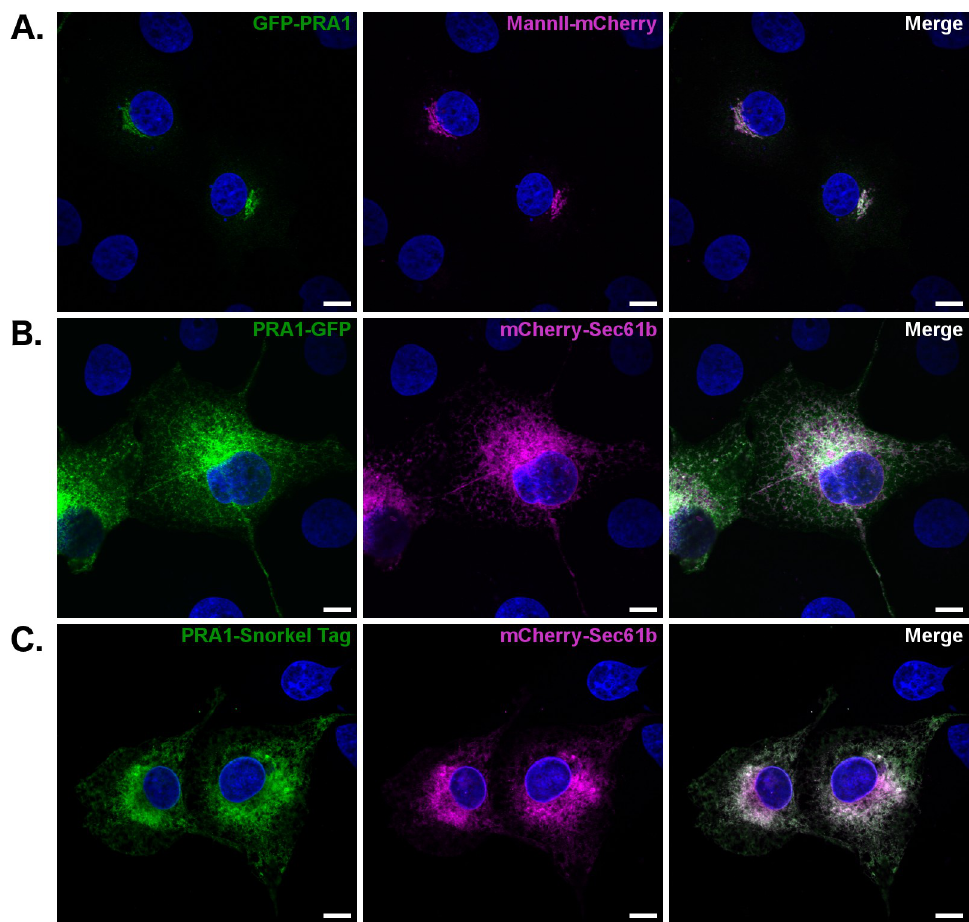
following constructs were expressed in COS-7 cells: (A) GFP-PRA1/MannII-mCherry (B) PRA1-GFP/mCherry-sec61b (C) PRA1-Snorkel-Tag/mCherry-sec61b. Images are representative of at least three transfections and are compiled